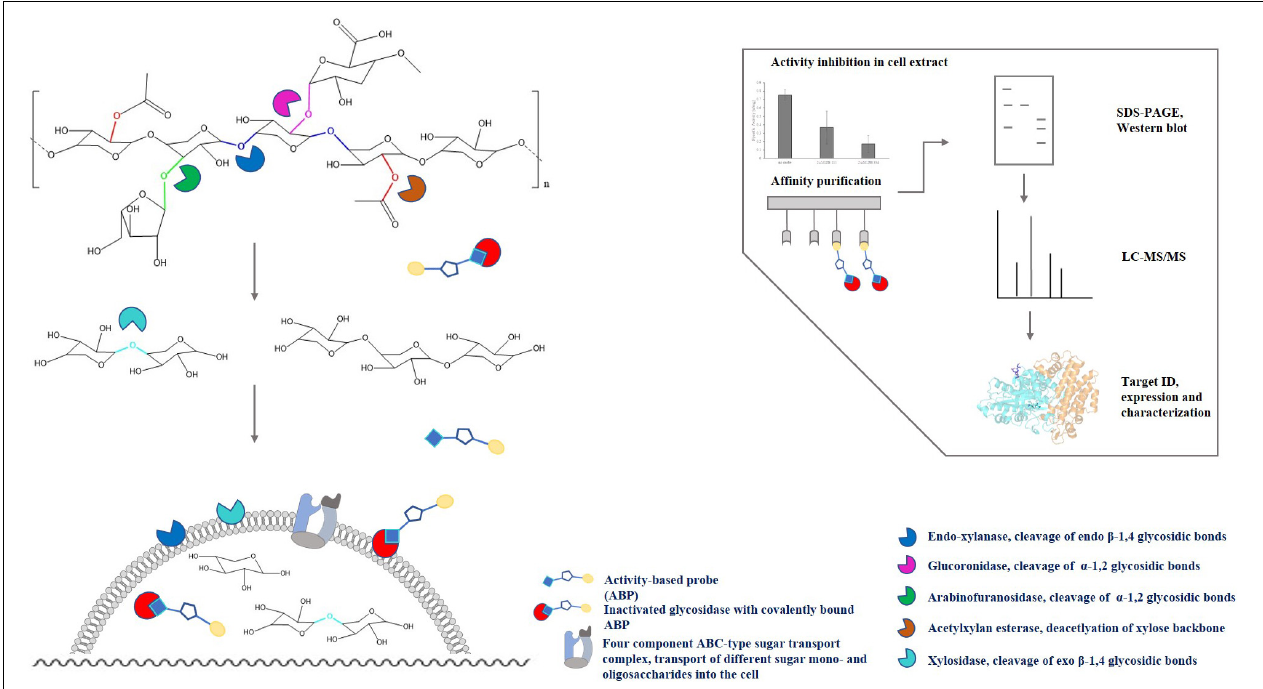
FIGURE 1 | Activity-based protein profiling for the identification of enzymes involved in xylan degradation in Thermococcus sp. strain 2319x1E. The schematic structure of hardwood xylan and the enzymes most commonly involved in its degradation as well as the chemical proteomics workflow is depicted. ABPs covalently and irreversibly modify active retaining glycosidases. The thus labeled and inactivated enzymes can be visualized on a gel/membrane or affinity purified via the linked biotin moiety (yellow circle) and subsequently analyzed by LC-MS/MS, followed by protein identification through matching the acquired spectra with a reference